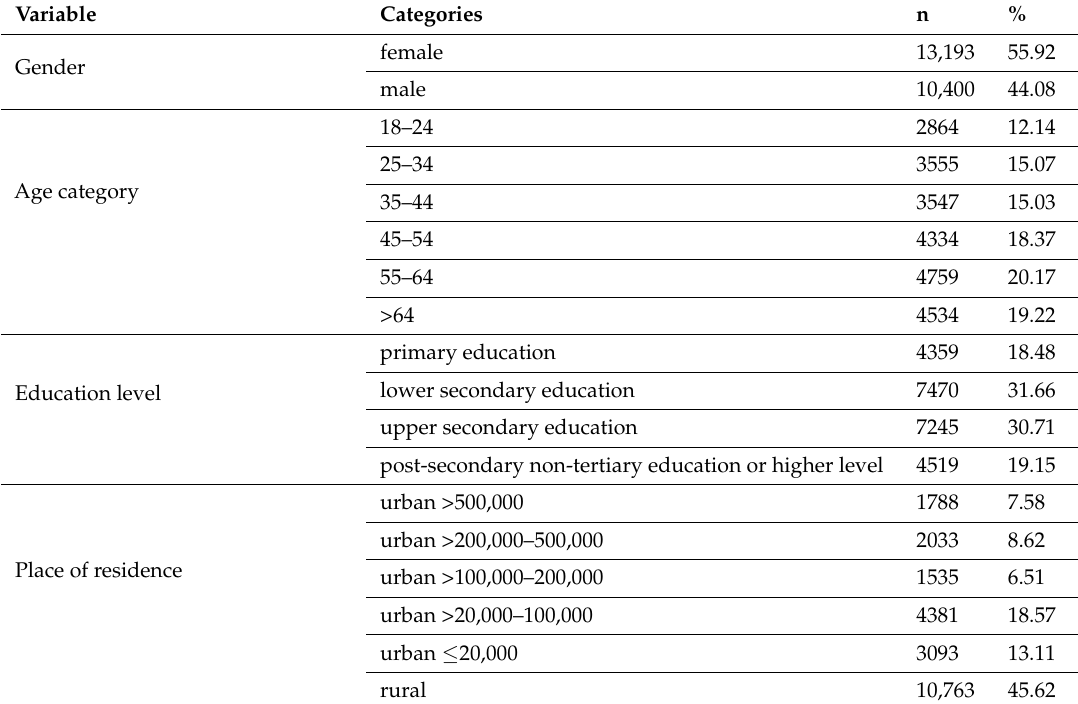
Table 1. Characteristics of the study population (weighted